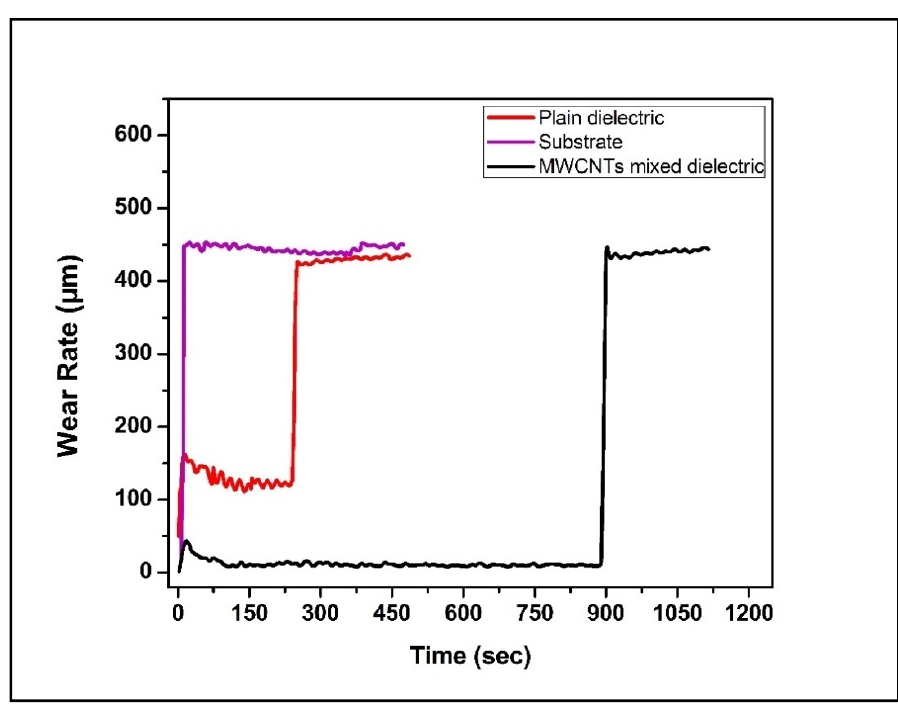
Figure 6. XRD spectra and crystallographic planes of MWCNTs treated sample (trial 17).